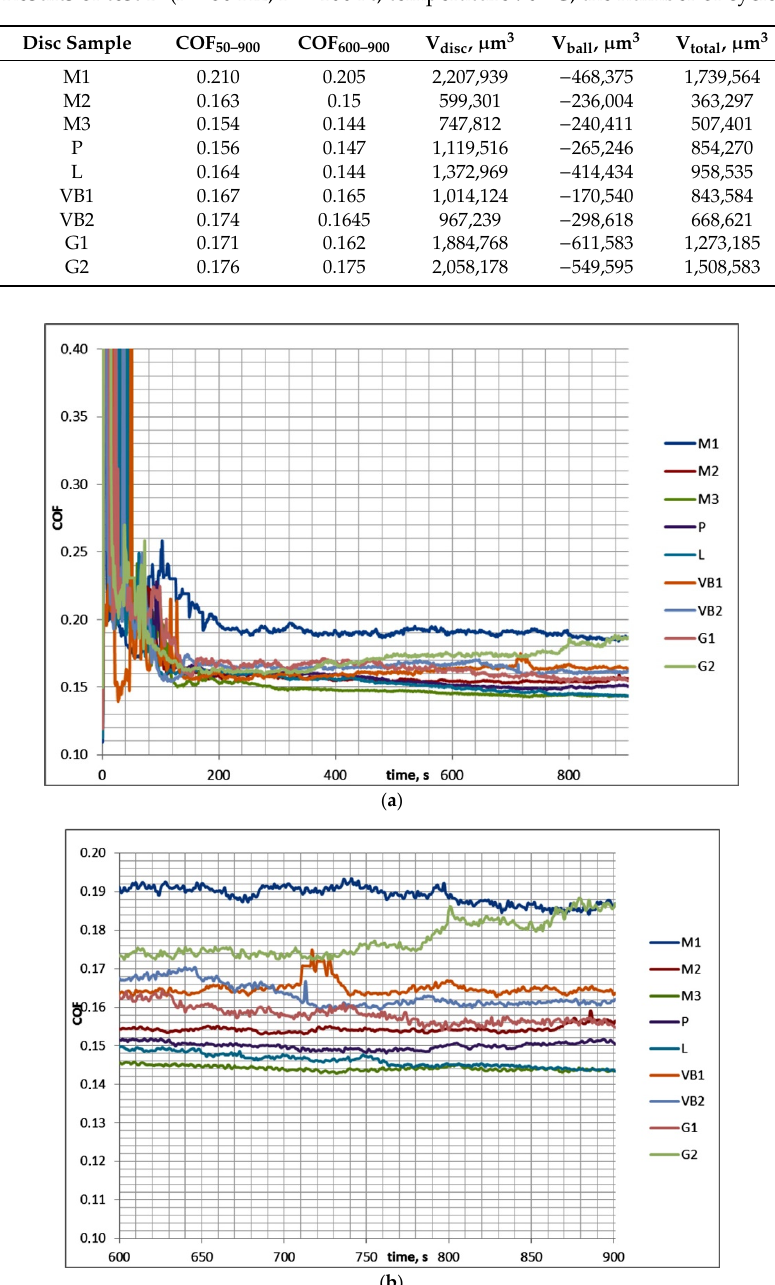
Figure 12. Friction coefficients for the whole of test D ( a ) and for its last 5 min ( b ).